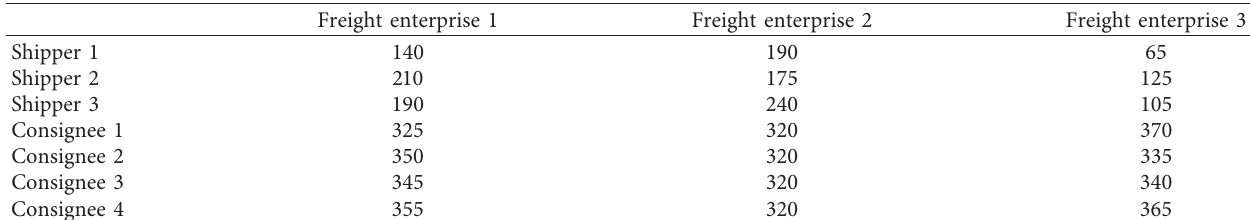
Table 6: The distance between nodes in the medium bulk cargo transport network (km).